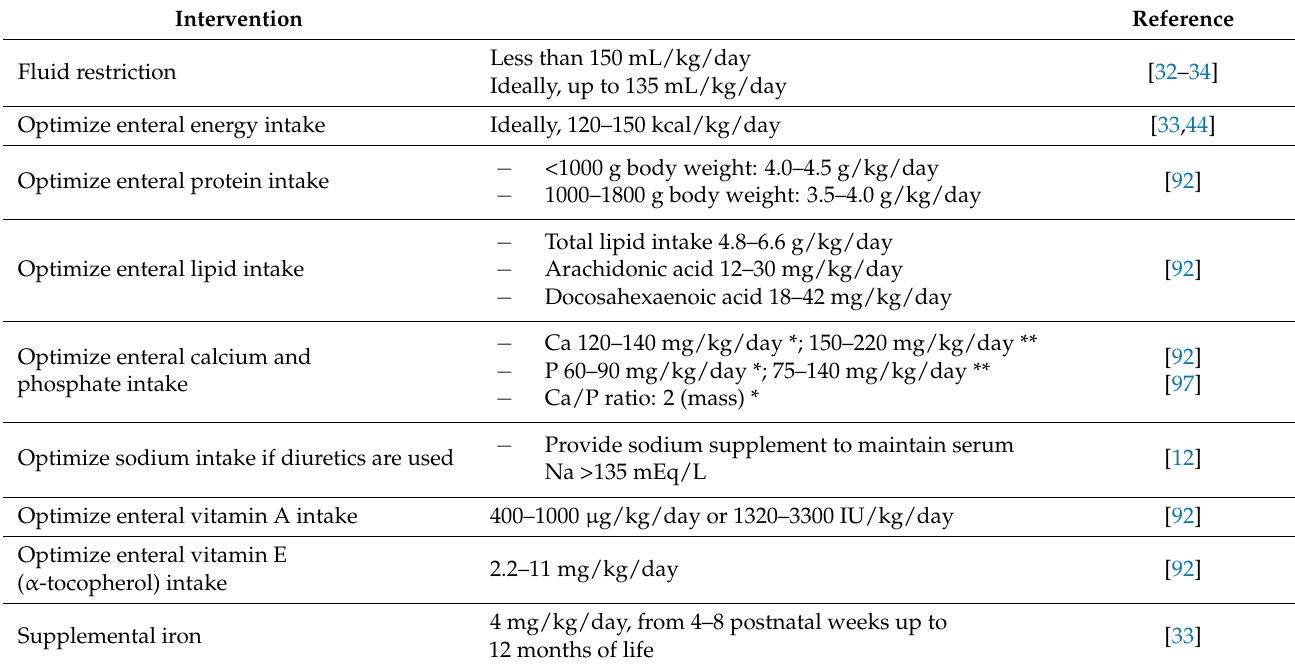
Table 2. Nutritional management in infants with established BPD, either in the hospital or after